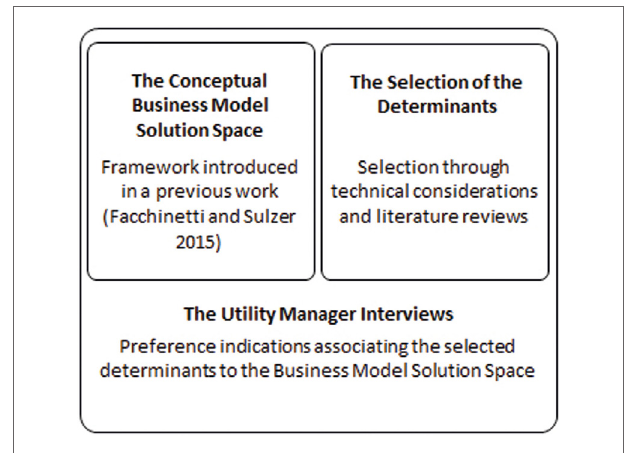
FigUre 1 | Methodological framework .